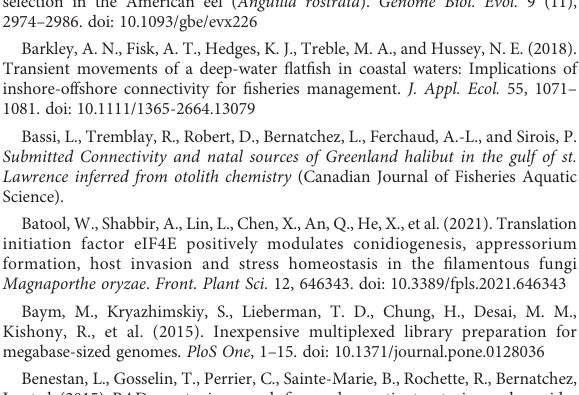
and temperature-related variables found to be signi fi cantly associated with allele frequencies. Black dots correspond to SNPs that are signi fi cantly associated with the environmental variables, while grey dots indicate non-outliers SNPs.